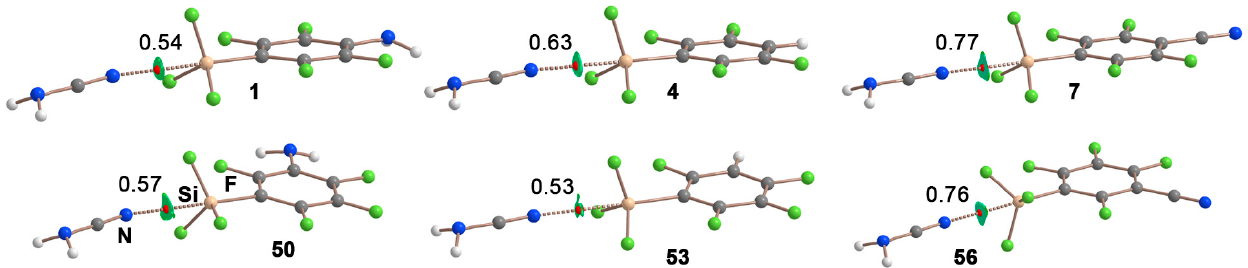
Figure 4. Distribution of critical points and bond paths in several tetrel bonding complexes. The intermolecular bond critical point (BCP) is denoted by a red dot. The bond path connecting the bond critical point is also represented. The value of the density at the BCP characterizing the TtB ( ρ × 10 2 , a.u.) is also indicated. NCI plot colour range –0.002 a.u. ≤ (sign λ 2 ) ρ ≤ –0.002 a.u.